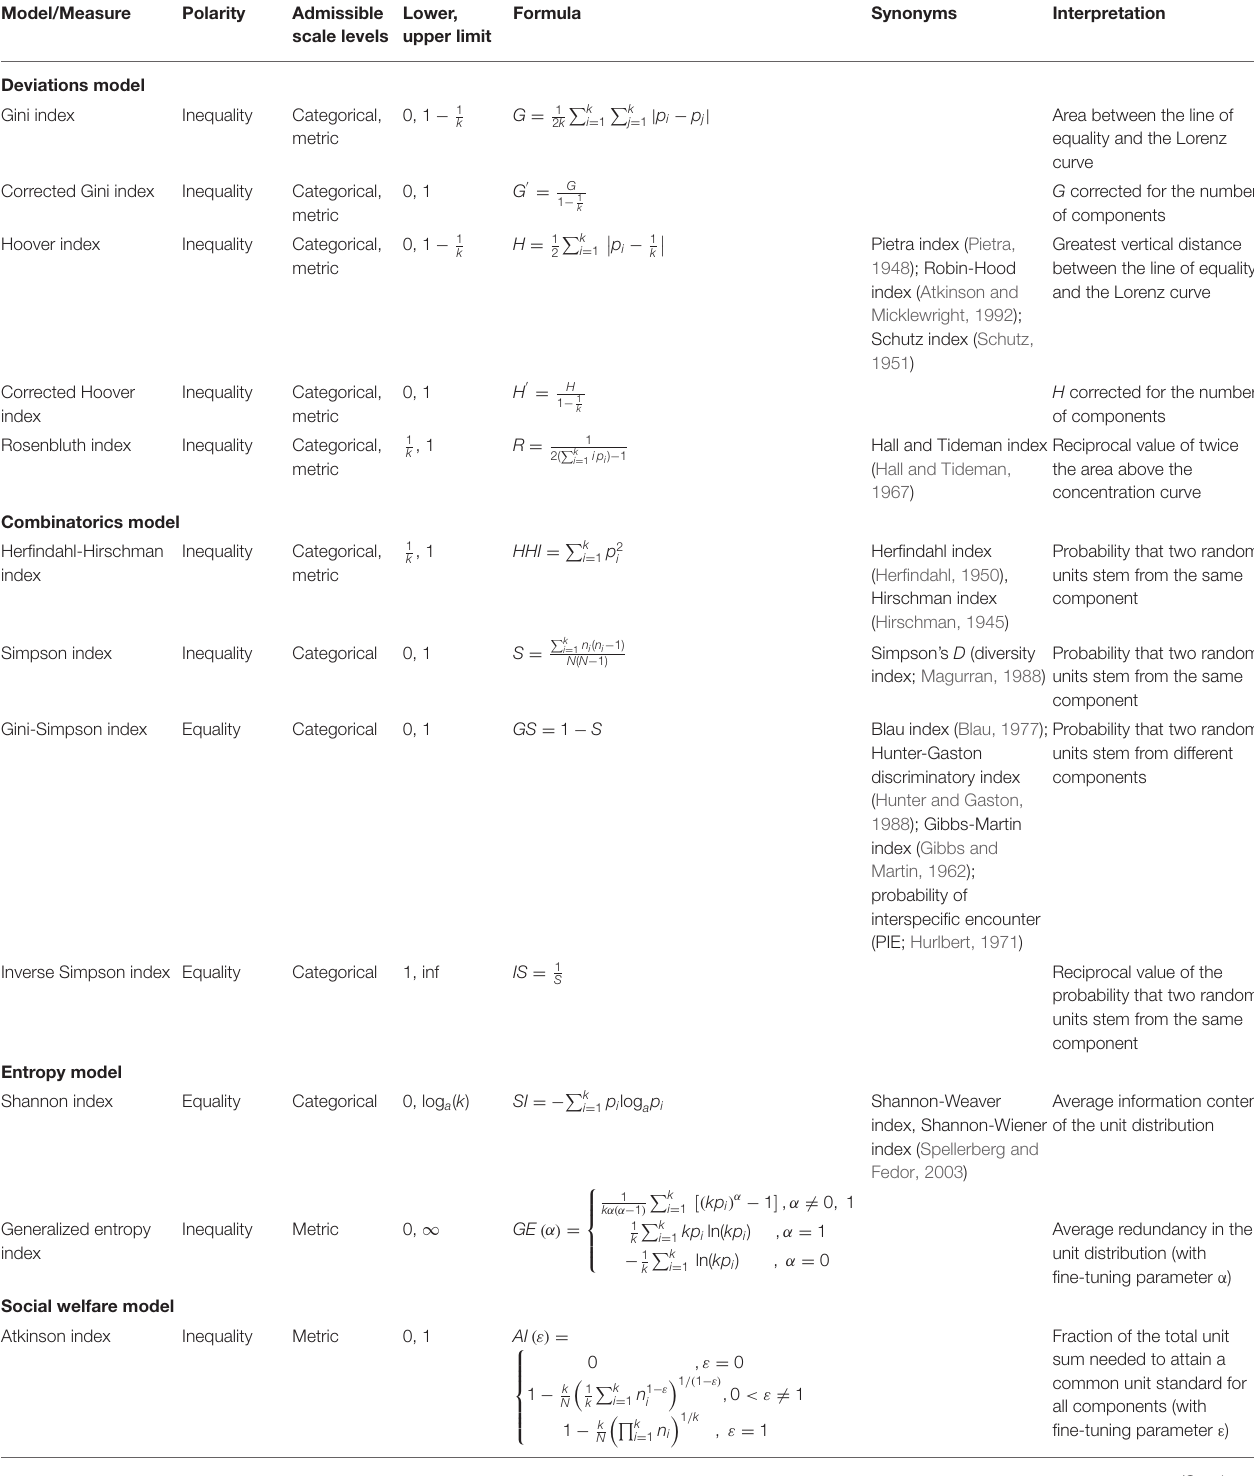
TABLE 1 | Overview of the statistical inequality measures covered in this practical primer and implemented in the companion Shiny app.